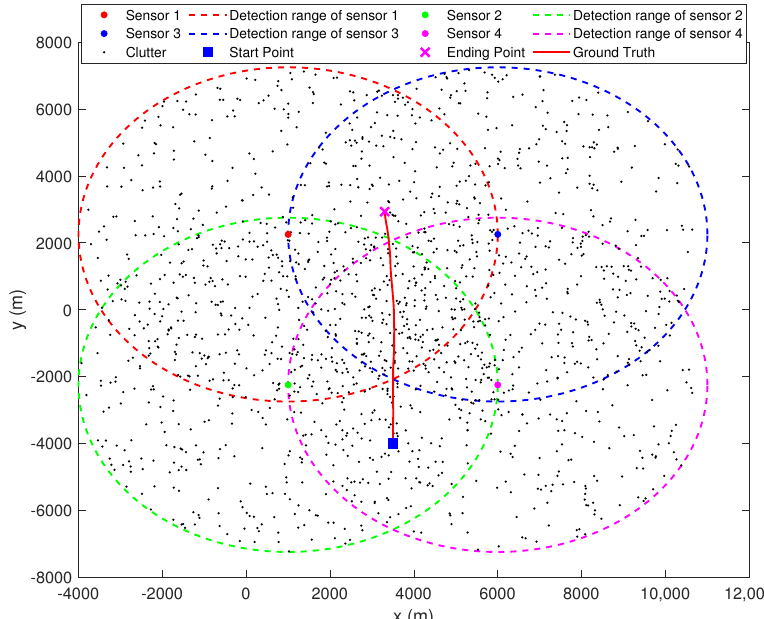
Figure 12. Scenario 3 for single target tracking with 4 passive